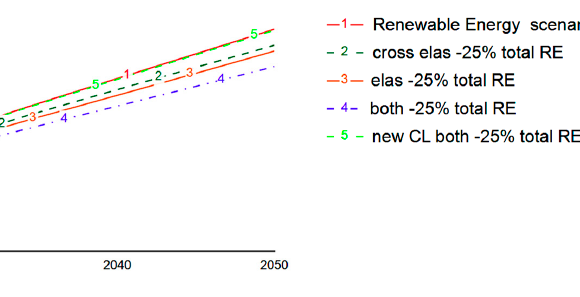
Table 8. Sensitivity analysis on conversion factor ES.